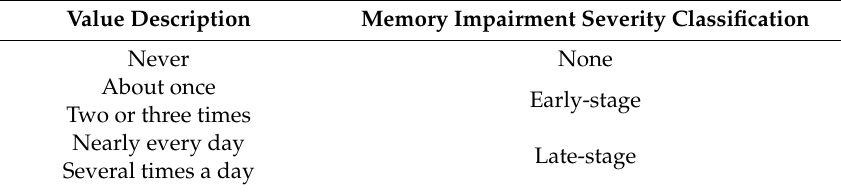
Table 1. The Severity of Memory Impairment Using NHANES 2011–2014 Memory